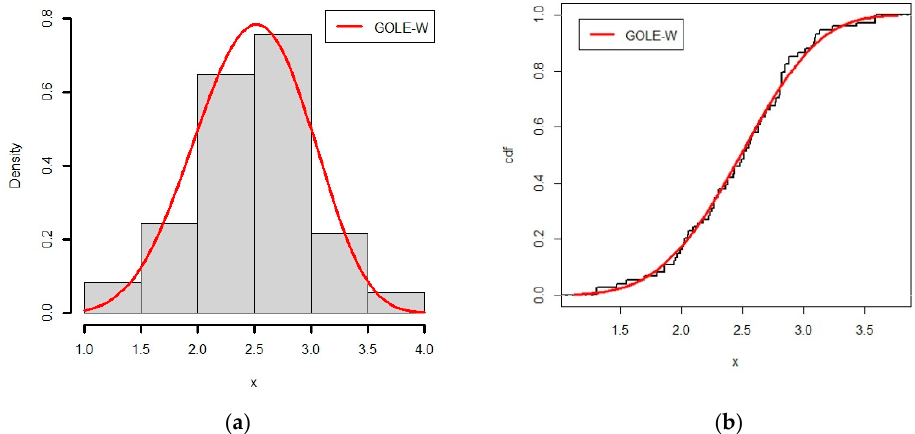
Figure 10. Plots of ( a ) the fitted PDF for the GOLE-W distribution and ( b ) estimated CDF for the GOLE-W distribution for data set I.